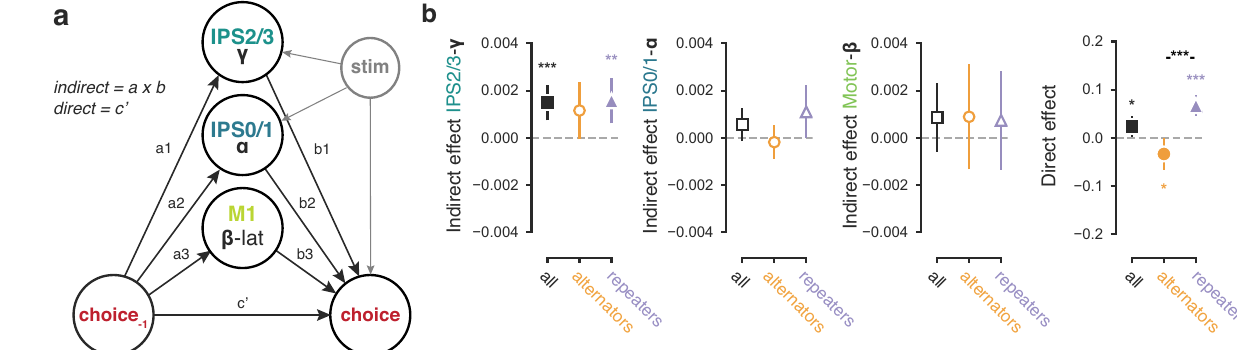
Fig. 6 | CorticalIPS2/3-gammasignalmediates choice history bias. a Schematic of mediation model.Alleffects pointingtothe binarychoicewerecomputed using logistic regression. b Mediation parameter estimates for the complete group ( n =60) as well as both subgroups ( n =25 alternators in orange, n =34 repeaters in purple). Left-right: indirect paths, quantifying mediation by neural signals. IPS2/3- gamma: all t (59)=3.971, p =0.0002; alternators: t (24)=1.948, p =0.0632; repea- ters: t (33)=3.310, p =0.0023. IPS0/1-alpha: all t (59)=1.592, p =0.1167; alternators: